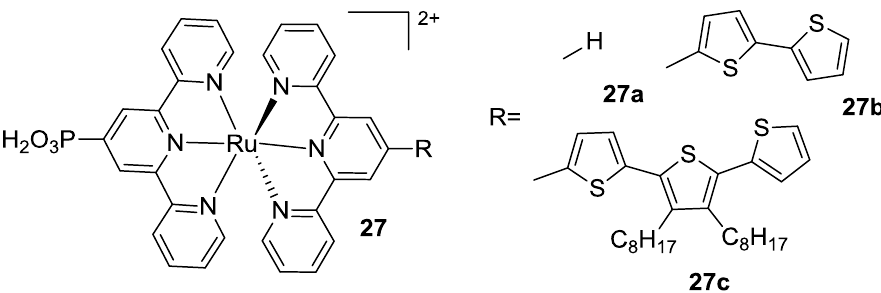
Figure 21. A first series of bis-tpy complexes proposed by Houarner et al. [107].